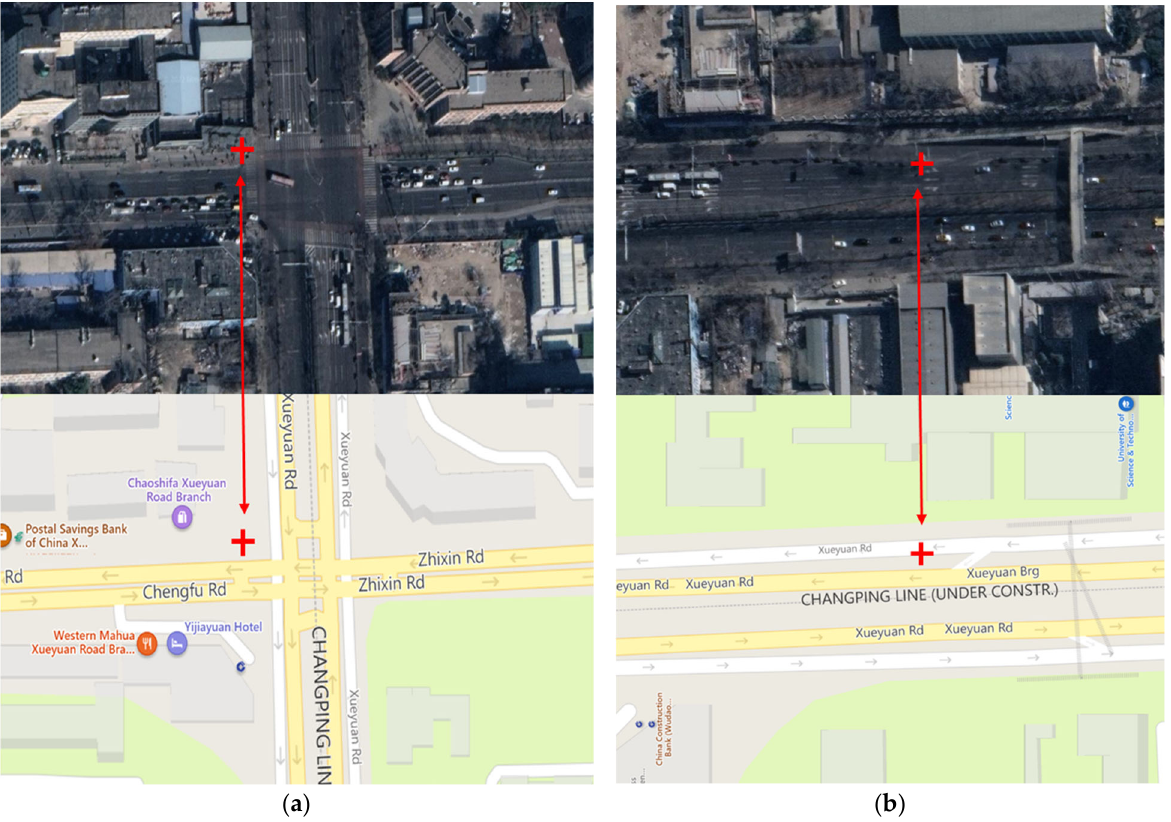
Figure 11. Two typical urban road scenes and the locations we selected for roadside LiDAR shown in satellite images and maps. ( a ) The intersection scene and the locations of roadside LiDAR. ( b ) The urban road scene and the locations of roadside LiDAR. Table 1. Laser ‐ ID ‐ sequence list of LiDAR.